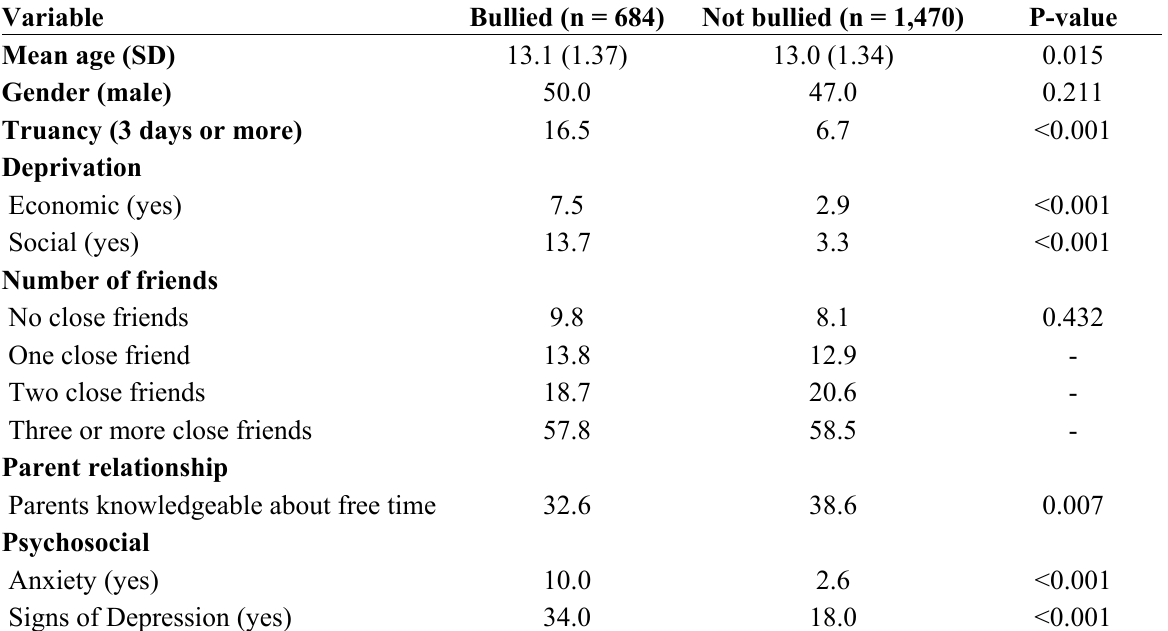
Table 2. Bivariate analyses of bullied vs . non-bullied adolescents in Dar es Salaam, Tanzania